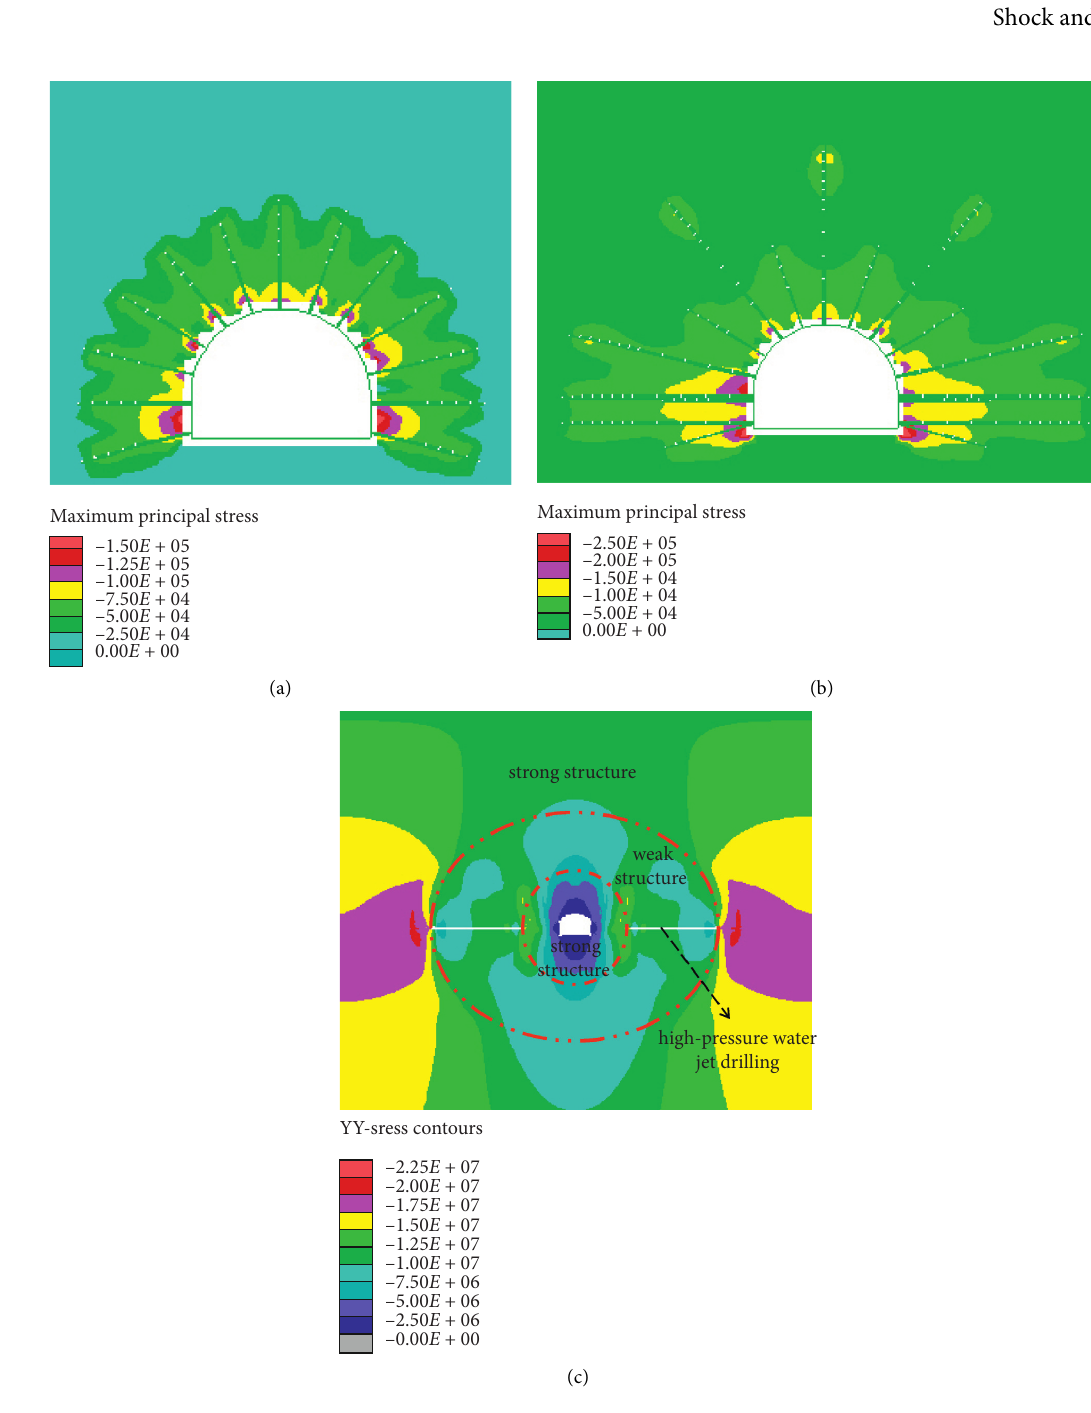
Figure 13: Numerical simulation results: (a) anchor net support; (b) anchor network cable is cooperatively supported; (c) after the high- pressure water jet roadway gang decompression on the basis of cooperative